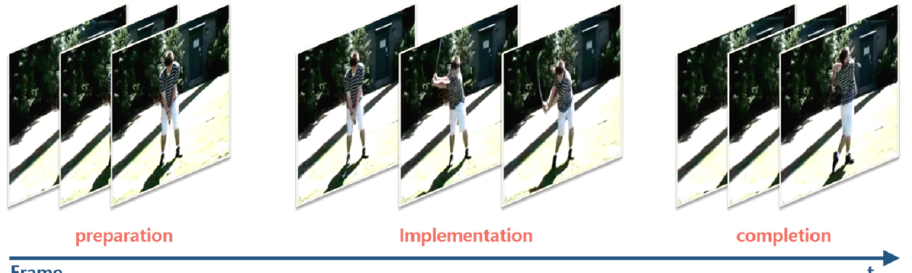
Figure 5. A golf swing action consists of three action elements including preparaion, imiplementation and